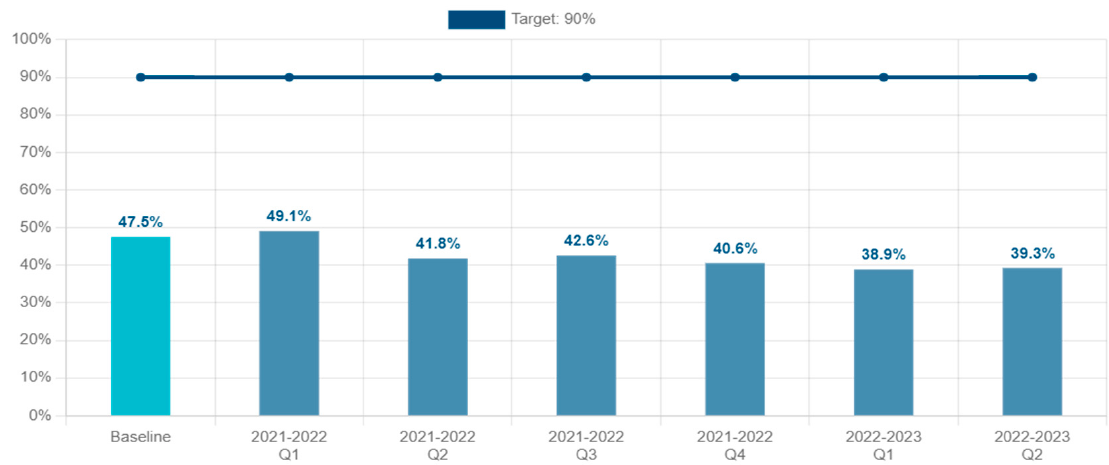
Figure 11. Percentage of endoscopic surgical services completed or wait times within benchmark [84].